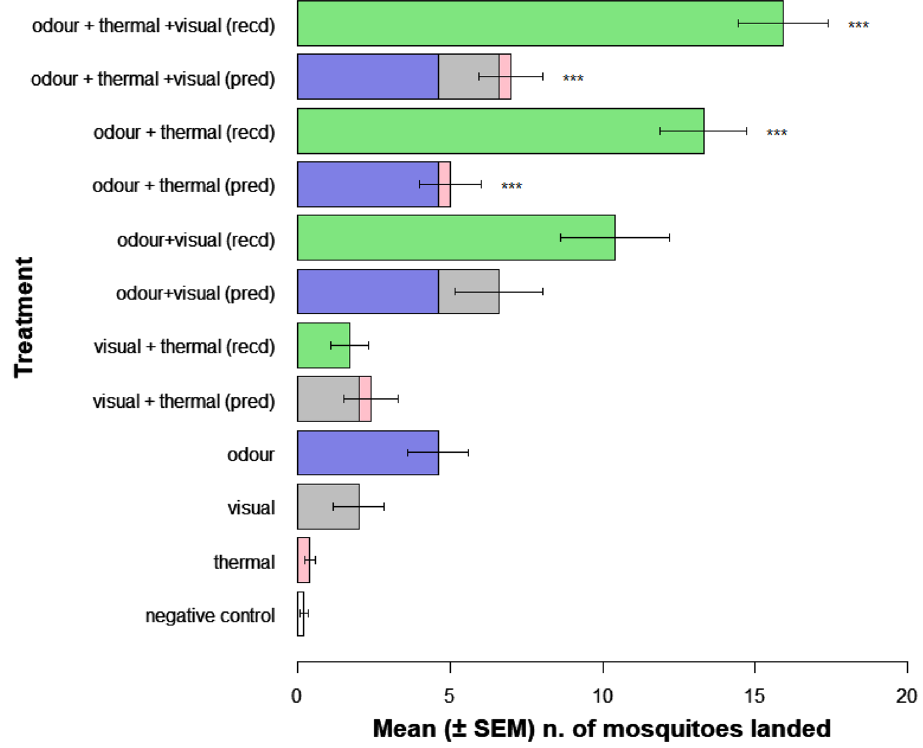
Figure 4. Predicted and recorded effects of host-associated stimuli on the mean landing response (± SEM) of host-seeking An. coluzzii, when stimuli were presented alone and in combination. Negative control is set based on the number of mosquitoes landing on a target when no thermal, visual or odour stimuli are presented. Recd, recorded mean from experiments; pred, additive predicted mean derived from simulated data set produced using recorded baseline values. ***Denotes significant difference at P < 0.001 between the recorded effect and the predicted effect for each respective